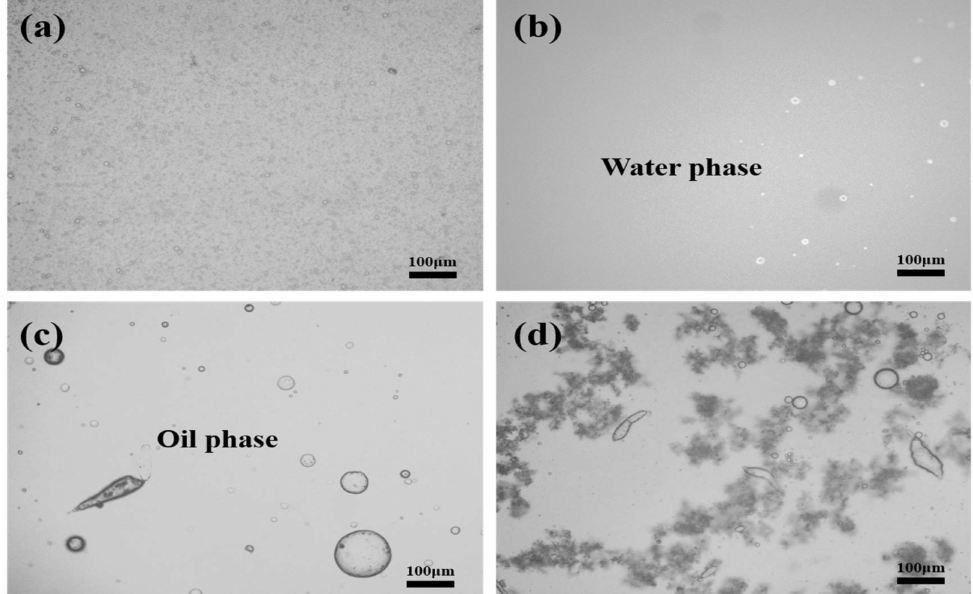
Figure 9. Micrographs of the oil–water mixture before and after demulsification: ( a ) the oil-in-water emulsion; ( b ) the newly separated water phase; ( c ) the newly separated oil phase; ( d ) Ti-Mt-APTES in oil-in-water